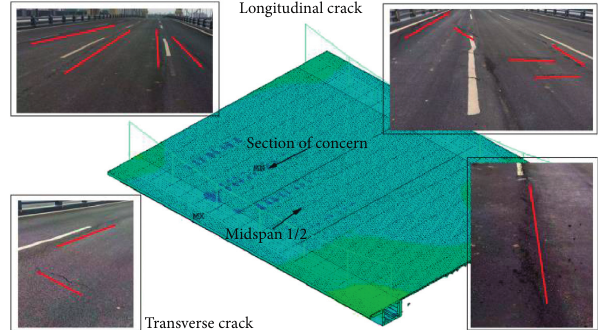
Figure 14: Cracks in the Yunlongwan Bridge deck